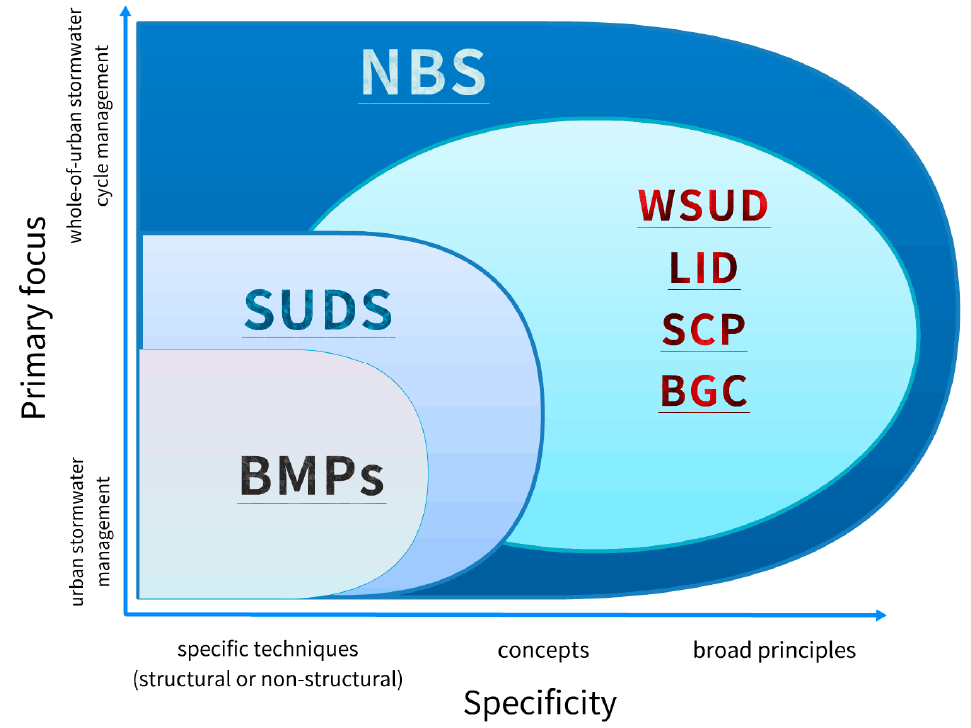
Figure 4. Relationship of Nature-Based Solutions (NBS), Best Management Practices (BMPs), Drainage Systems (SuDs), Water Sensitive Urban Design (WSUD), Low Impact Development (LID), Sustainable Drainage Systems (SuDs), Water Sensitive Urban Design (WSUD), Low Impact Blue–Green Cities (BGCs), and SCP. Source: Development (LID), Blue–Green Cities (BGCs), and SCP. Source: authors.